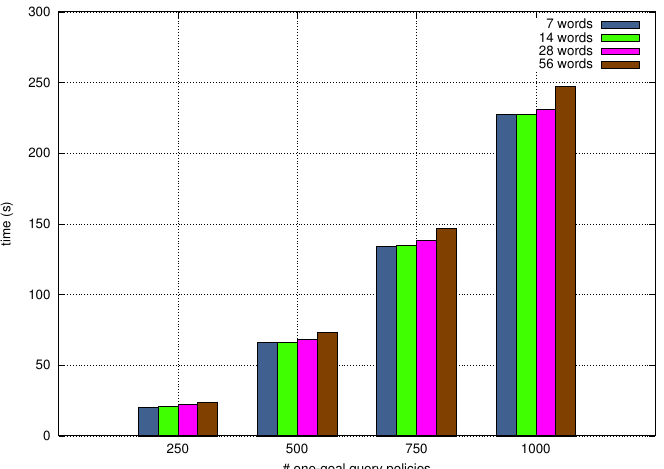
Figure 13. End-to-end processing time by policy